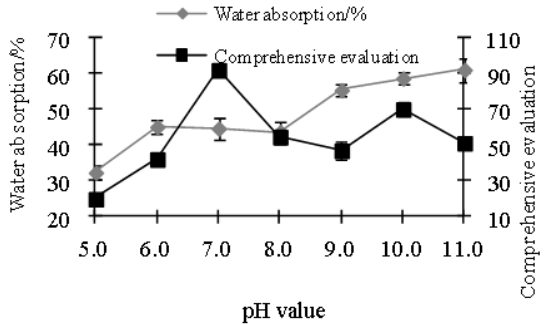
Figure 5. Effects of pH on tensile strength and elongation rate.